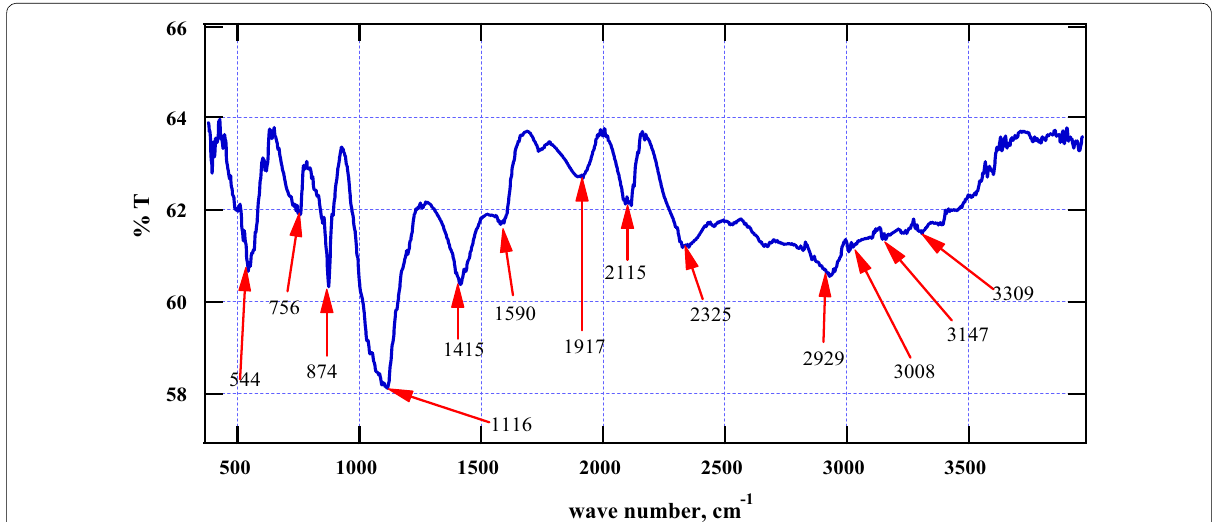
Fig. 5 FTIR absorption bands for the char formed from the co-pyrolysis of croton biodiesel and conventional diesel (FTIR absorption spectrum for the blank is reported in Additional file 1: Figure